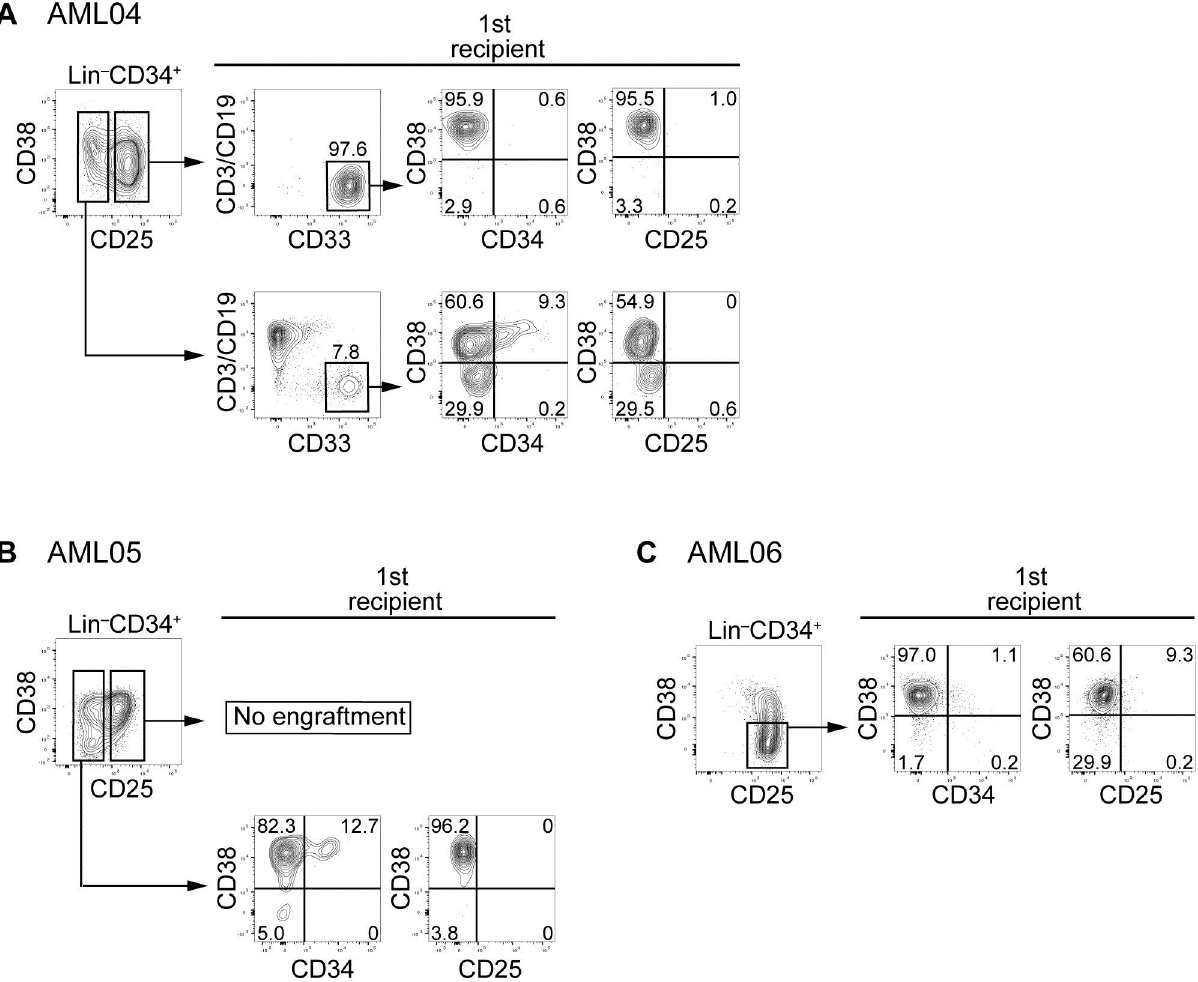
Fig 3. Reconstitution of human leukemia with distinct expression of CD25 at the primary transplantation into mice, with failure at the secondary transplantation. Lin – CD34 + CD38 – cells from AML04 (A), 05 (B), and 06 (C) were sorted into CD25-positive and -negative populations, and then transplanted to primary recipients. Expression of CD3/CD19, CD33, CD34, CD38, and CD25 on engrafted cells was analyzed. The hCD45 + cells were sorted and transplanted to secondary recipients. No engraftment was observed in mice transplanted with hCD45 + cells from AML04, 05, or 06.